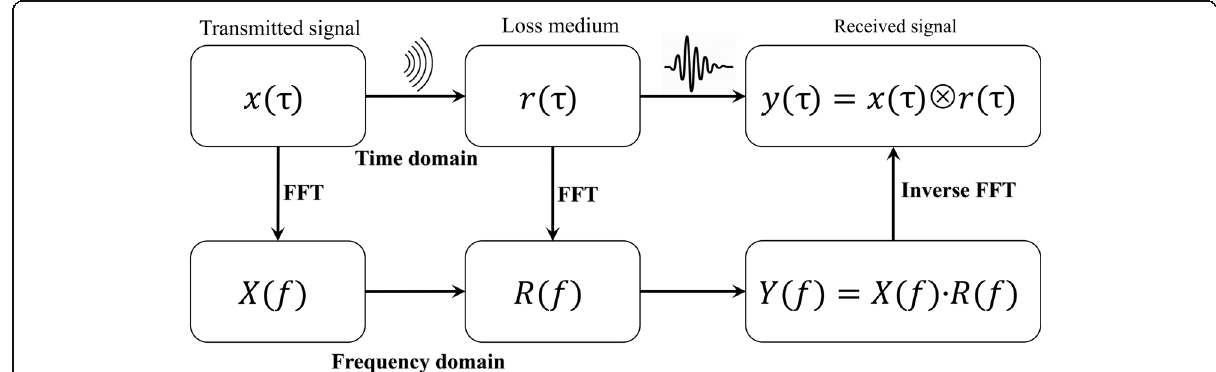
Fig. 3 The LPR data are treated as a linear signal system. Fourier transformation and Inverse Fourier transformation are used to transform the signal system from time domain to frequency domain (Rabiner and Gold, 1975). In the time domain, the received signal y ( τ ) is derived based on the convolution between the transmitted signal x ( τ ) and that of the loss medium r ( τ ). In the frequency domain, the amplitude spectrum of the received signal Y ( f ) equals the product of the amplitude spectra of the transmitted waveform X ( f ) and the loss medium R ( f